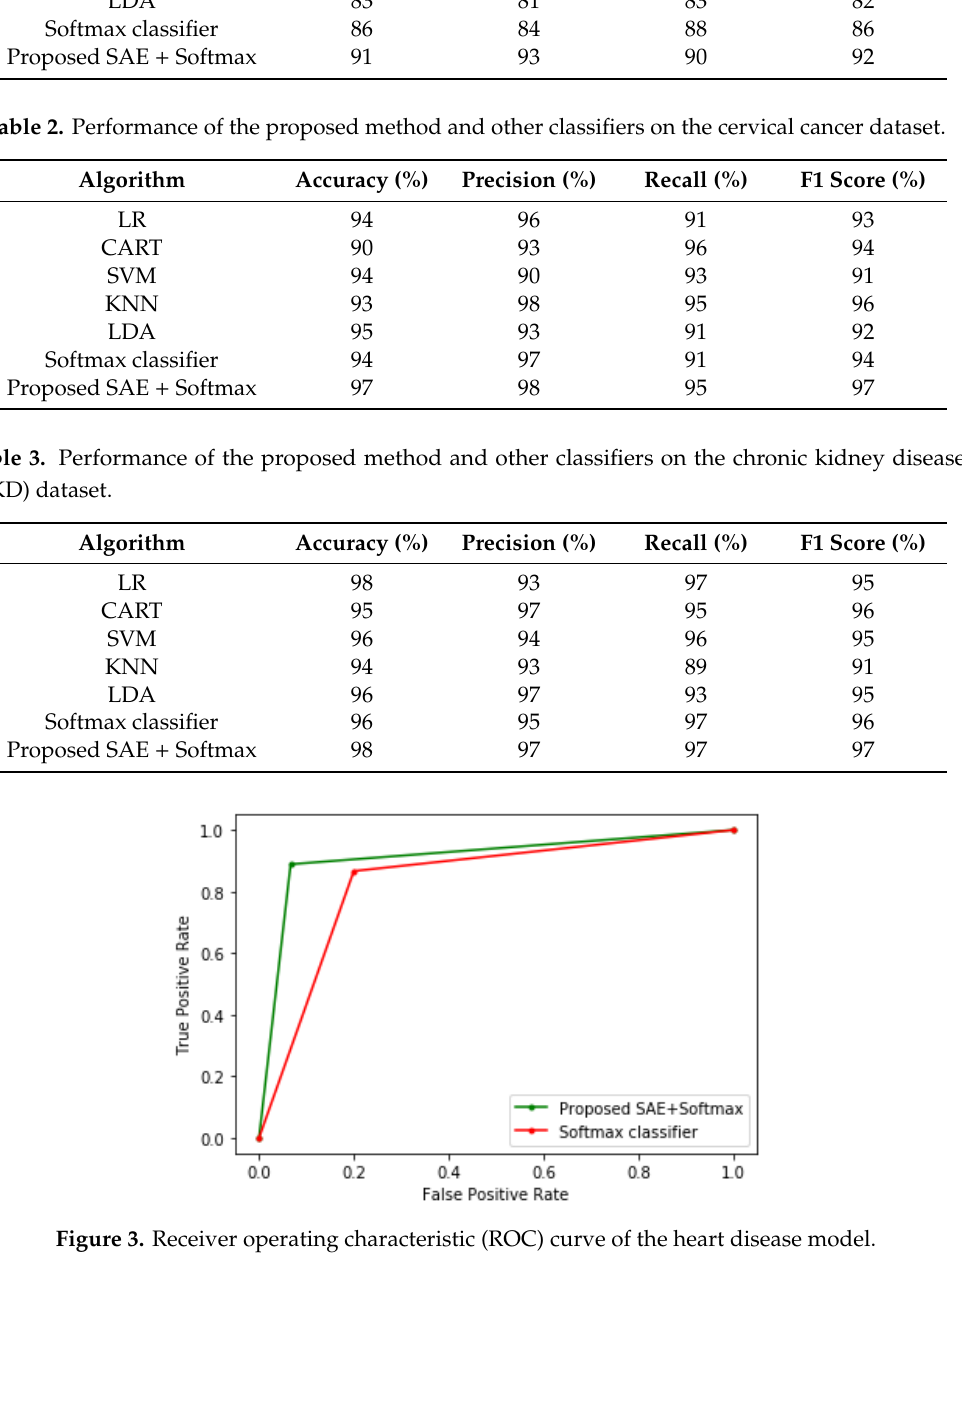
Figure 4. ROC curve of the cervical cancer model. Table 3. Performance of the proposed method and other classifiers on the chronic kidney disease (CKD) dataset. Algorithm